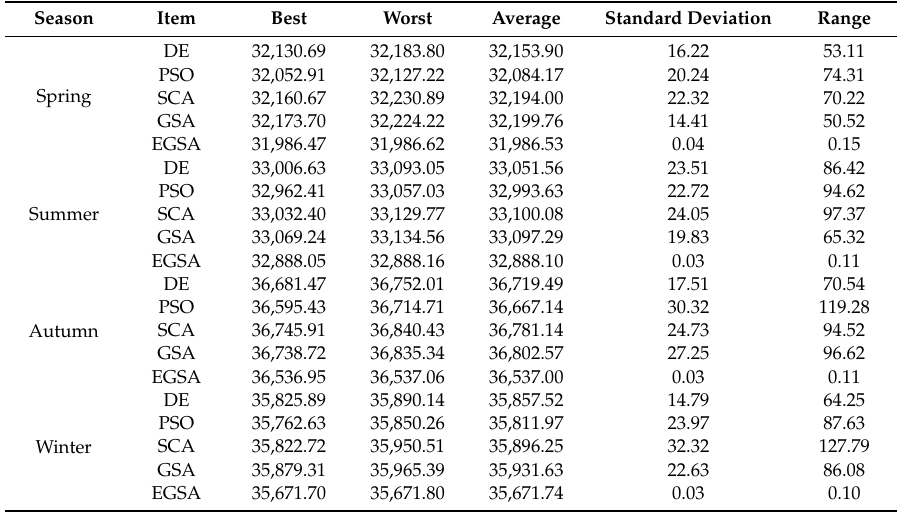
Table 7. Statistical results of the 5 methods in 20 independent runs for 4 cases of peak operation.